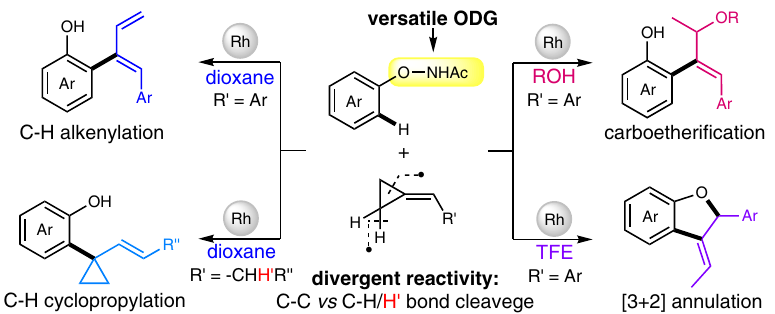
Fig. 1 Chemodivergent assembly of ortho -functionalized phenols. a Representative molecules containing the privileged ortho -functionalized phenol core. b , c TM-catalyzed C – H functionalization for the construction of ortho -functionalized